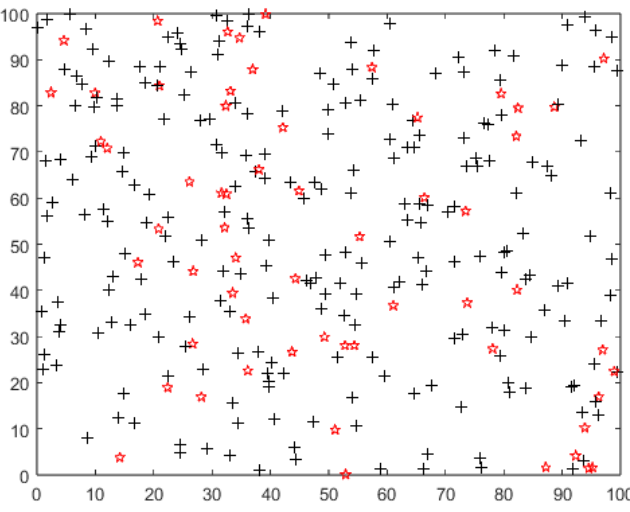
Figure 8. A 100 m × 100 m heterogeneous network with 300 nodes randomly deployed. “+” denotes a node with initial energy of 0.2 J, “red star” denotes a node with initial energy of 0.1